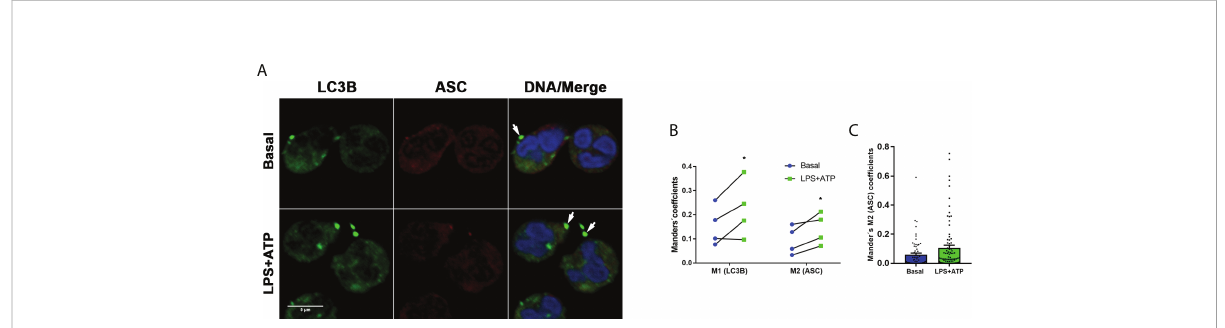
FIGURE 3 In fl ammasomes are targeted to autophagosomes. (A) Representative CLSM images of neutrophils stimulated or not with LPS and 2 hours later treated or not with ATP. At 4 h post-LPS stimulation, cells were fi xed, permeabilized and stained with speci fi c antibodies anti-LC3B (green) and ASC (red). Images are representative of experiments with 4 different donors. (B) Manders´ coef fi cients (M1; the amount of vesicular LC3B that colocalizes with ASC) and M2 (the amount of ASC that colocalizes with LC3B) calculated by image quanti fi cation of experiments performed